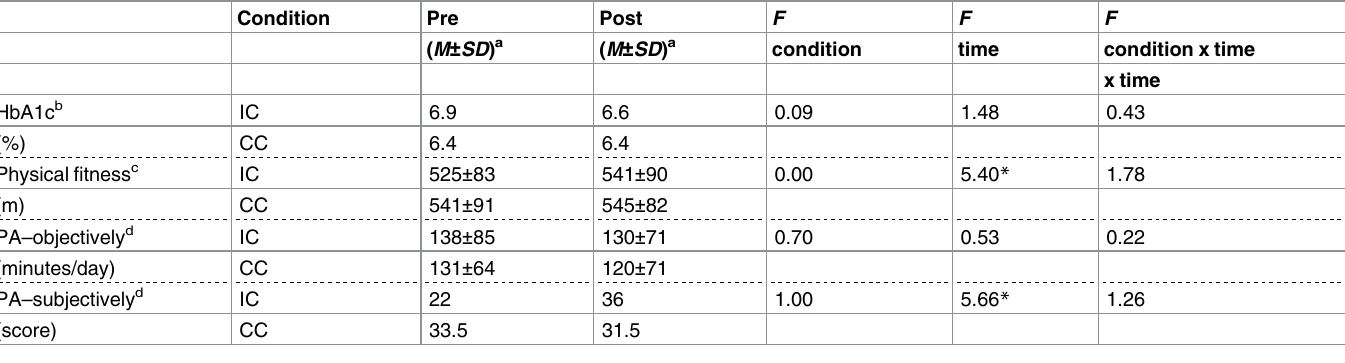
Table 6. Long-term effects–with